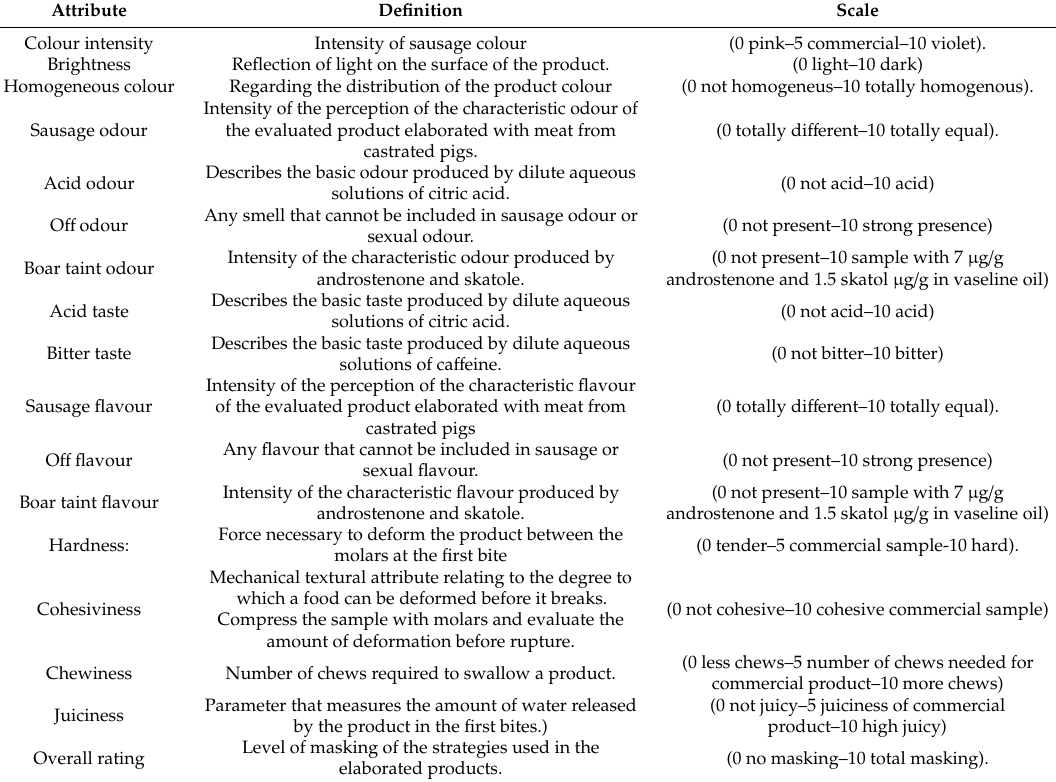
Table 2. Definition of attributes used in sensory